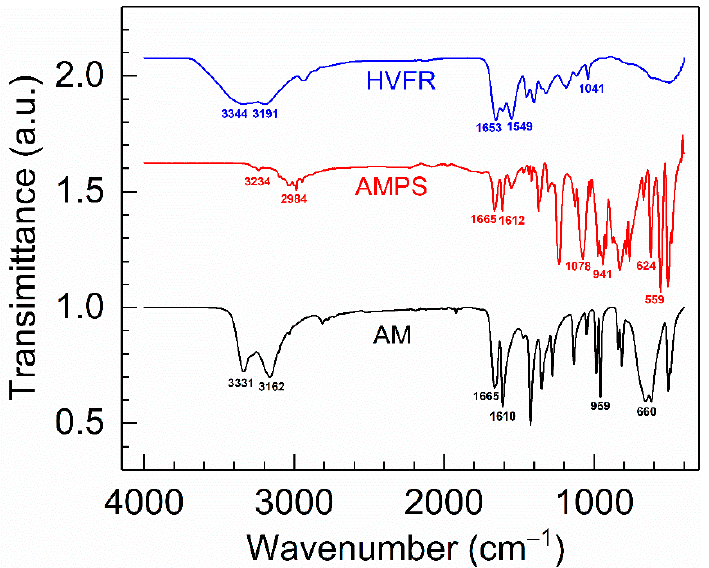
Figure 1. Comparison of the FTIR spectra of copolymer HVFR versus monomers AM and AMPS.